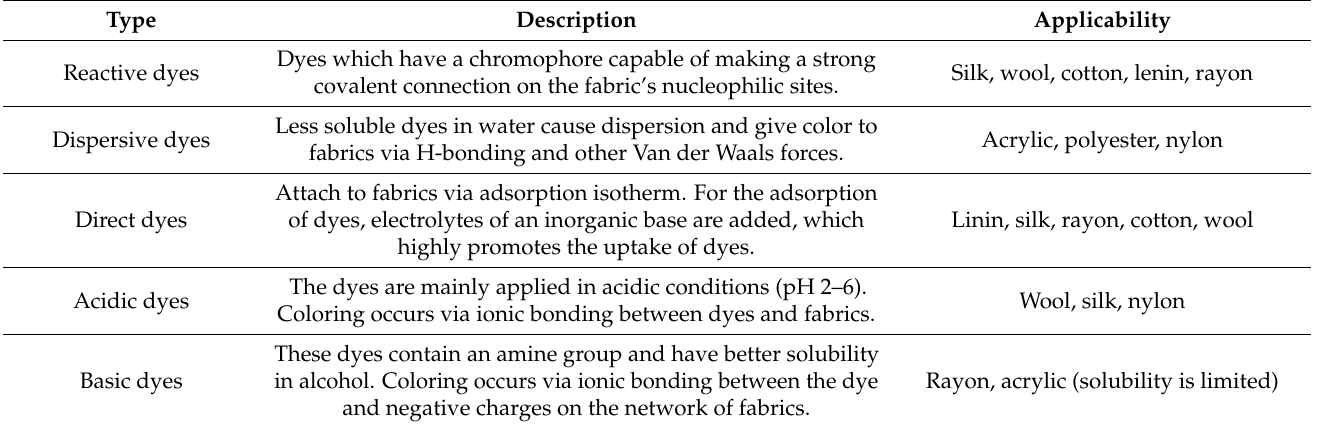
Table 1. Description of different types of